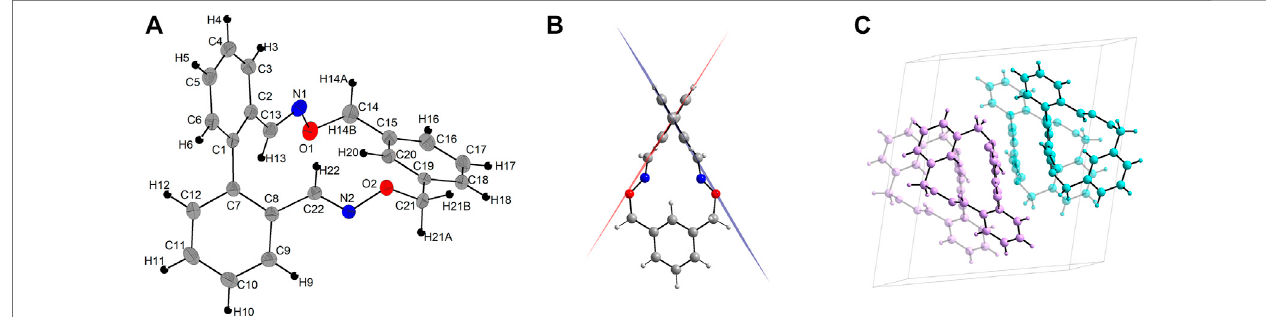
FIGURE 3 | (A) Thermal ellipsoid representation (25% probability) of the molecular structure of 4. (B) Top view showing the torsion angle between the planes of phenylgroupsinbiphenyl backbone. (C) Packingviewshowingthefourmoleculespresent intheunitcell. Thepairofenantiomersaredepictedintwodifferentcolorsfor clarity (aqua for the P enantiomer and pink for the M